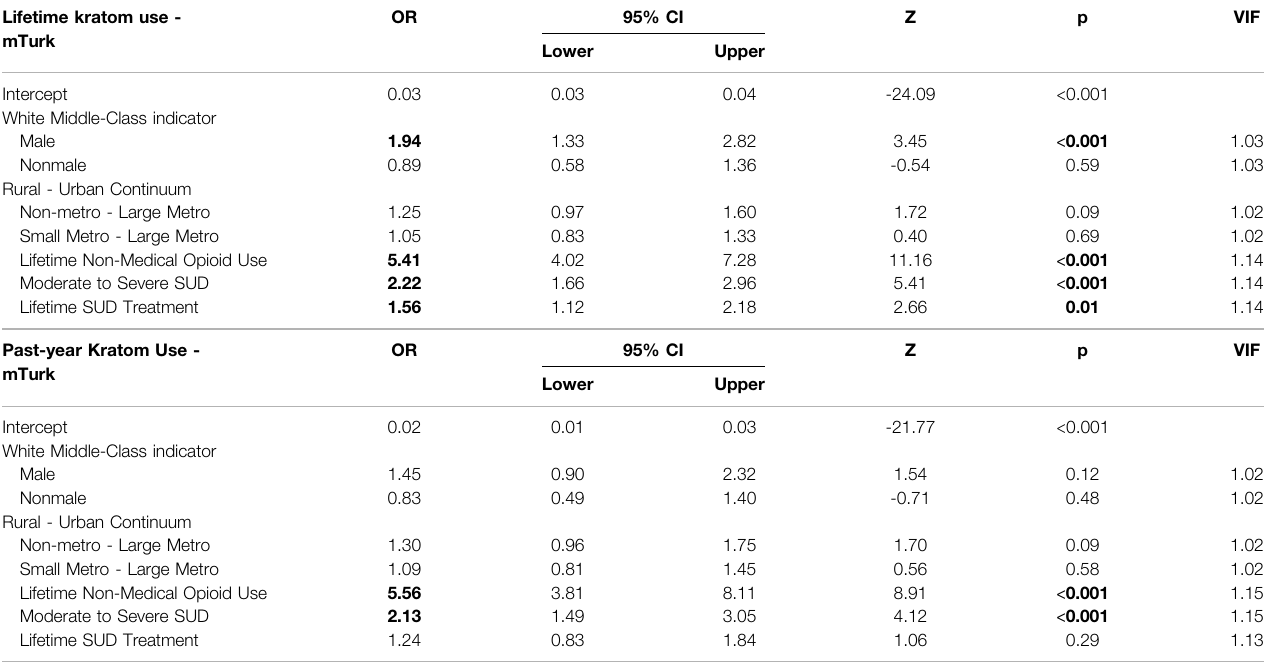
TABLE 4 | Multiple logistic regression models using online crowdsourced data to examine the relationship between a “ white middle-class ” indicator and kratom use while controlling for substance use factors. Lifetime kratom use - mTurk